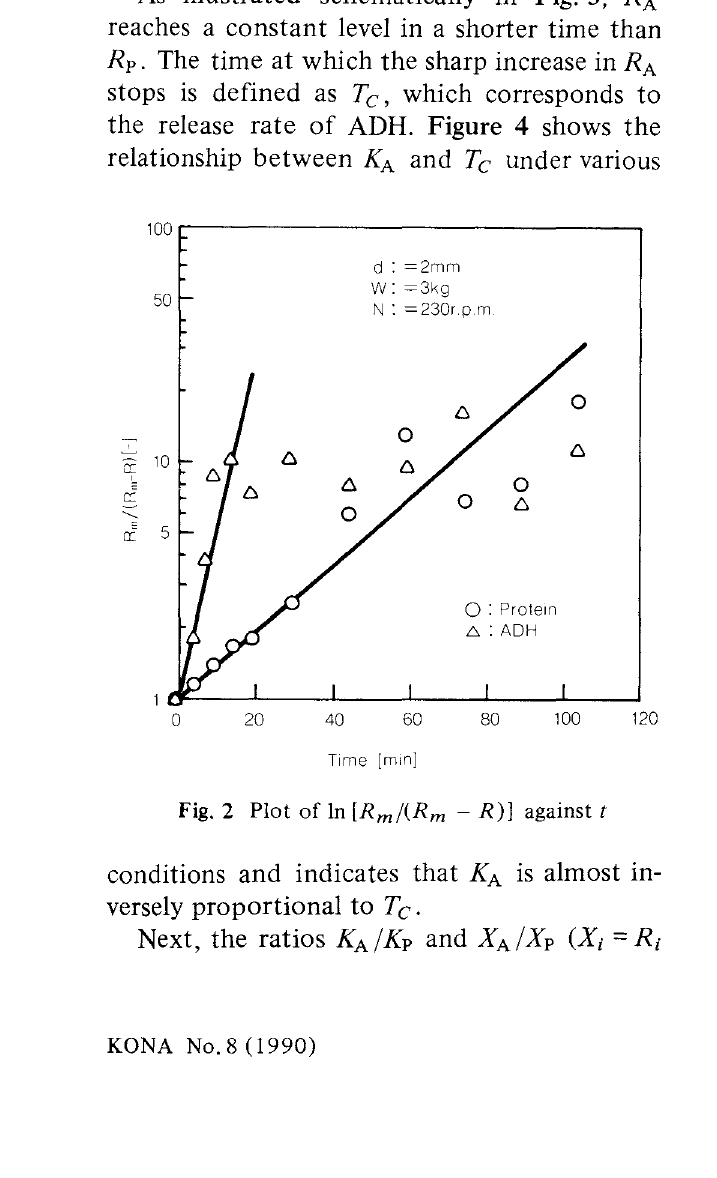
Fig. 3 Definition of a release selectivity between ADH and